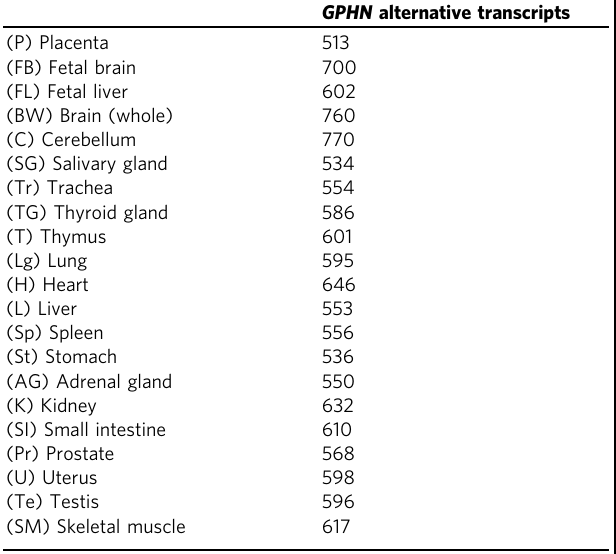
Table 2 Splice variants identi fi ed in each tissue.